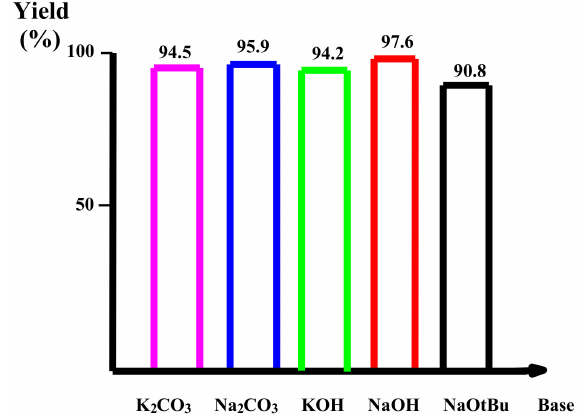
Figure 2. Product yields in Suzuki–Miyaura reaction of 4-bromobenzonitrile with phenylboronic acid catalyzed by 3